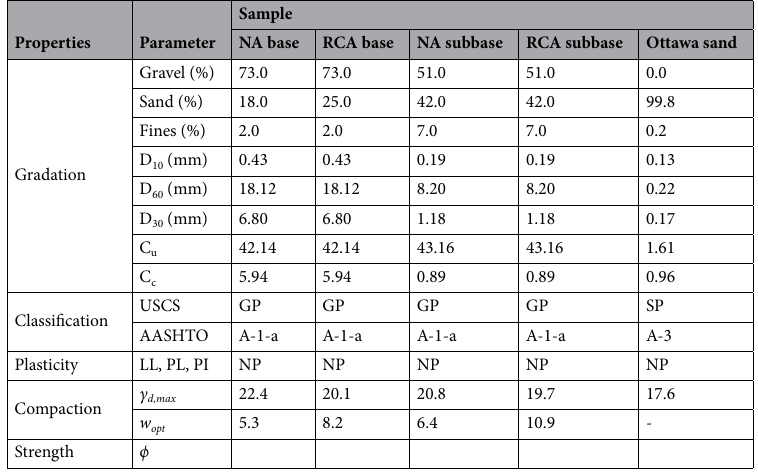
Table 1. The physical properties of RCA, NA, and Ottawa sand samples. γ d,max maximum dry unit weight, w opt optimum water content, LL liquid limit, PL plastic limit, PI plasticity index, D 10 size at which 10% is finer by weight (effective particle size), D 60 size at which 60% is finer by weight, D 30 the size at which 30% is finer by weight, C u uniformity coefficient, C c gradation coefficient, ϕ shear strength angles.